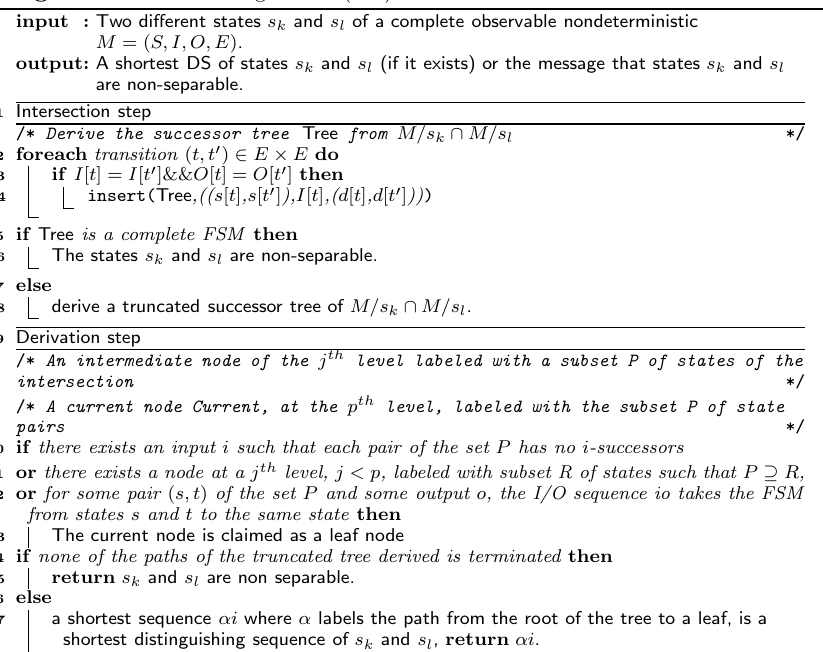
Algorithm 1: Exact Algorithm